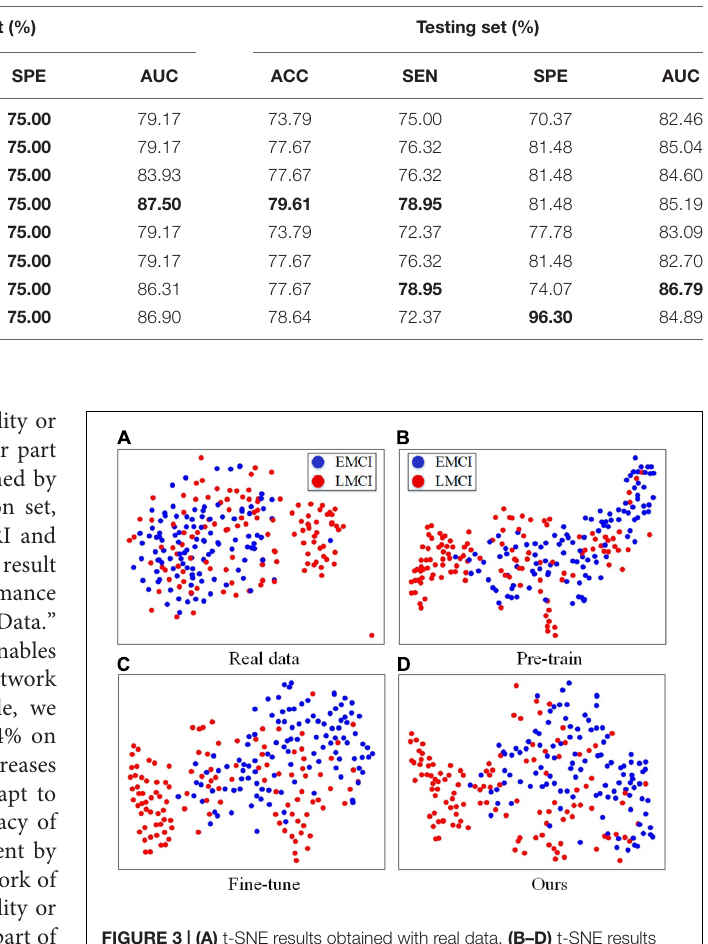
FIGURE 3 | (A) t-SNE results obtained with real data. (B–D) t-SNE results obtained with the fused features of the pretrained classification model, fine-tuned model of the traditional GAN, and fine-tuned model produced by our